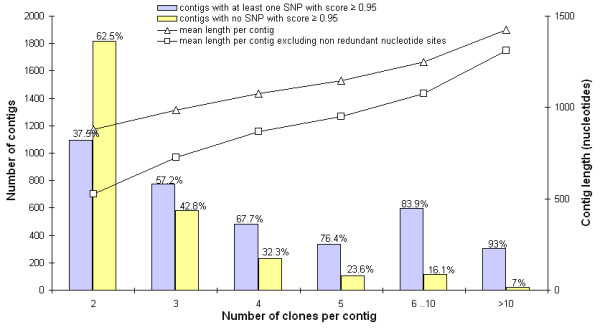
Number of contigs including in silico SNPs detected with PSNP ≥ 0.95 . Mean size of the contigs according to the length of the consensus sequence or mean size of the alignment per contig according to the number of clones.